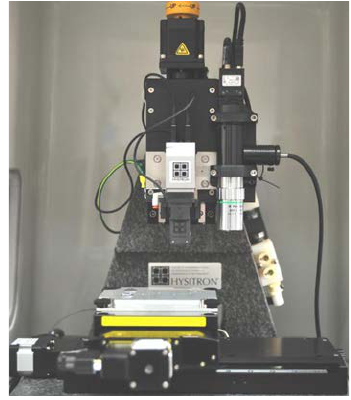
Figure 1. TI premier nano-indenter.